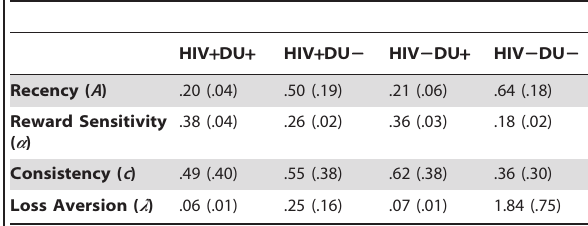
Table 3. Means and (standard deviations) of computational modeling parameters.